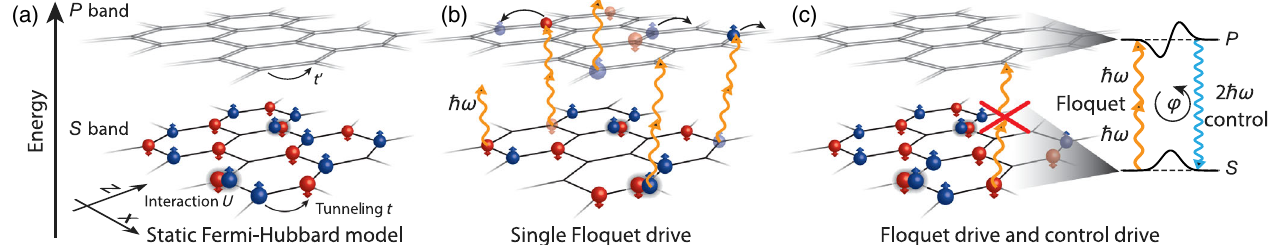
FIG. 1. Two-frequency driving suppresses dissipative coupling to higher bands. (a) Ultracold fermionic atoms in two internal states ↑ ; ↓ occupy a three-dimensional hexagonal optical lattice ( y direction omitted for clarity). They are described by the ground-band Fermi-Hubbard model with characteristic energies t (tunneling) and U (on-site interaction), while energetically higher-lying bands (tunneling t 0 ) are not populated in the absence of periodic driving. Here, only the fifth band is shown, which originates from hybridized ( P ) orbitals in the x direction. (b) Periodic driving close to resonance with an interband transition leads to dissipation in the ground-band Fermi-Hubbard system, originating from excited-band tunneling ( t 0 ), inhomogeneities, or subsequent excitation to even higher bands. The first relevant resonance is a two-photon process at frequency ω (shown in orange), whereas the single-photon transition is located at 2 ω (blue). (c) When applying two driving frequencies simultaneously with matched transition strengths, tuning the relative phase φ coherently enhances or suppresses dissipative coupling to higher